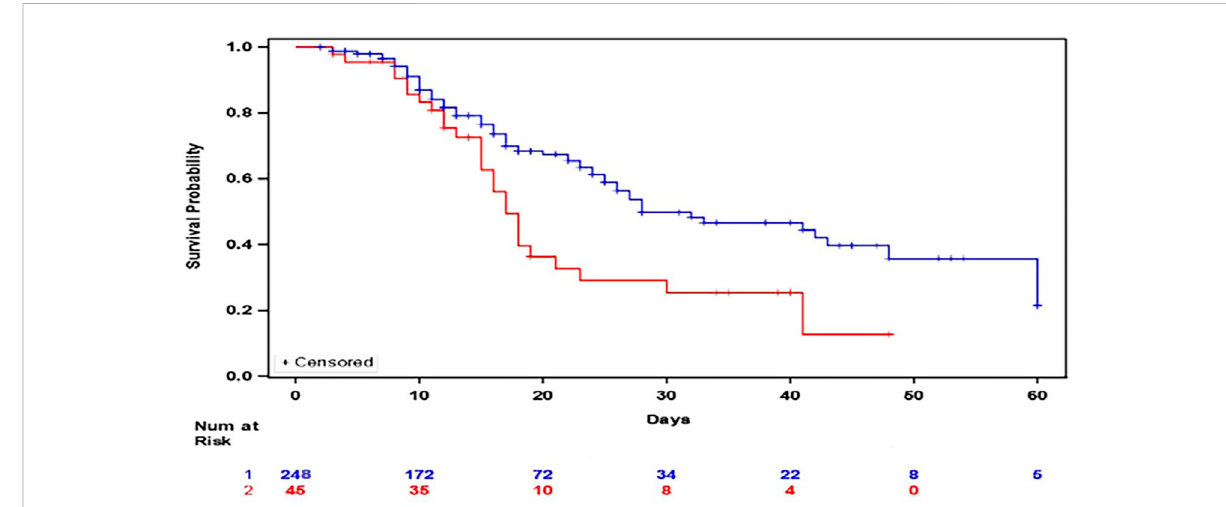
FIGURE 1 Kaplan Meier Plot of In Hospital Survival between patients who received methylprednisolone, hydroxychloroquine, and azithromycin (Blue) versus those who received methylprednisolone